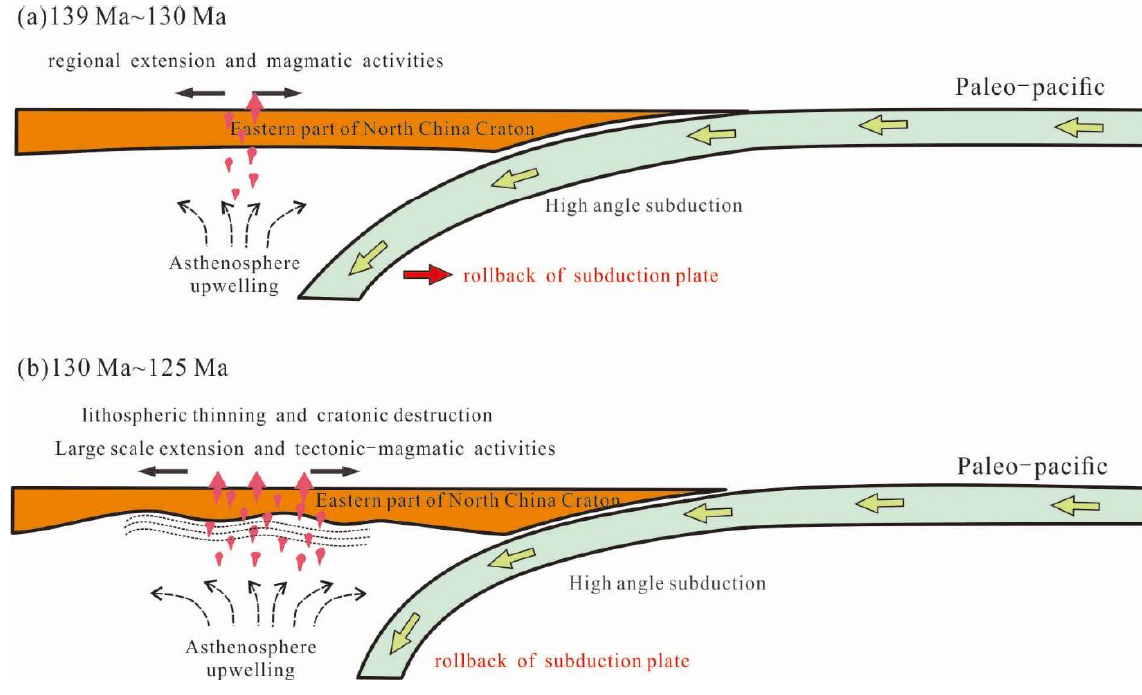
Figure 11. The tectonic setting of the eastern part of the North China Craton from 139 Ma to 125 Ma (modified after reference [5]). ( a ): The tectonic model for eastern part of North China Craton during 139 - 130 Ma ( b ): The tectonic model for eastern part of North China Craton during 130 - 125 Ma